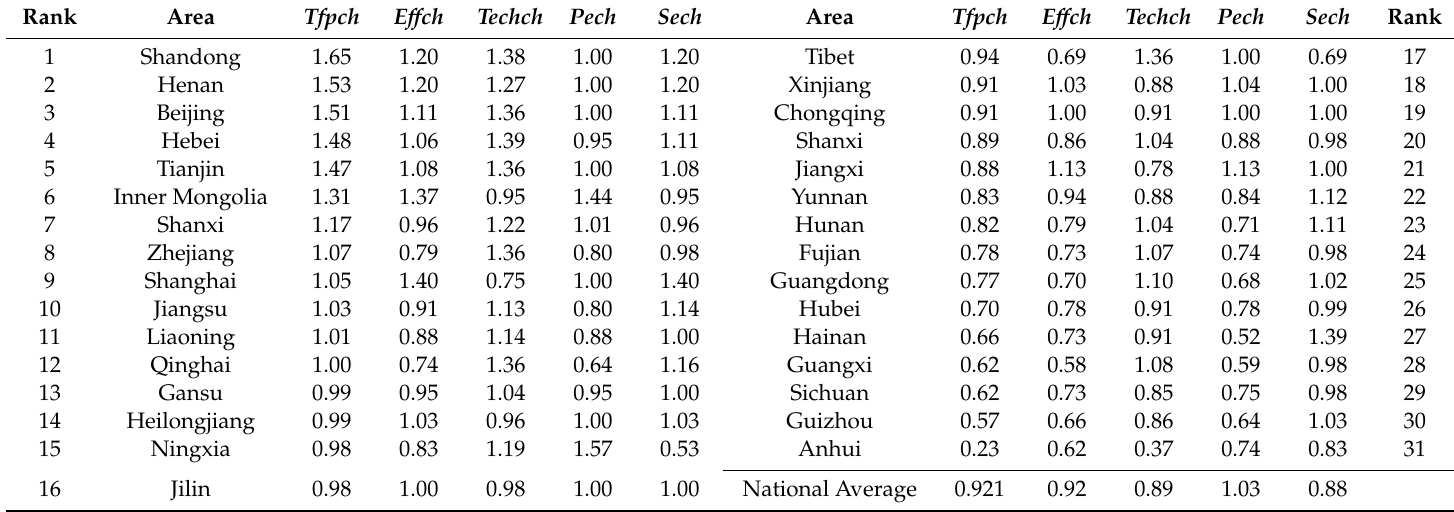
Table 4. Tfpch index summary of grain production e ffi ciency for 31 provinces from year 2003 to